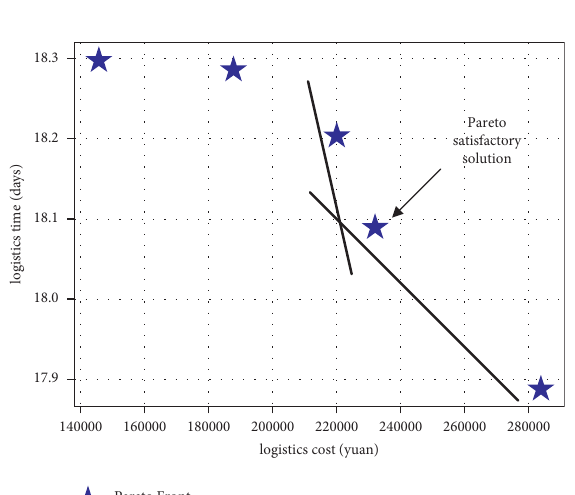
Figure 5: Baoji-New Delhi optimal path Pareto optimal solution